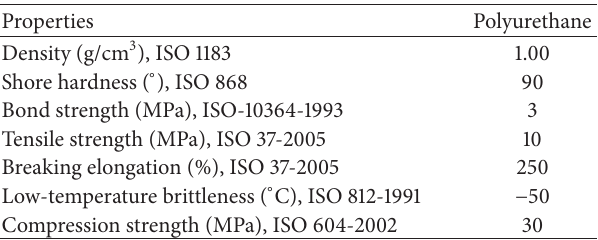
Table 2: Physical and mechanical properties of